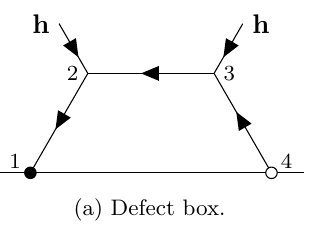
Figure 8 . 1-loop Feynman diagrams whose BRST variation could in principle necessitate a correction to the w, w OPEs. The undirected horizontal line represents the defect supported on L 0 , and the solid and empty dots represent couplings to w, ˜ w on the defect respectively. We have labelled the vertices of the first diagram for later